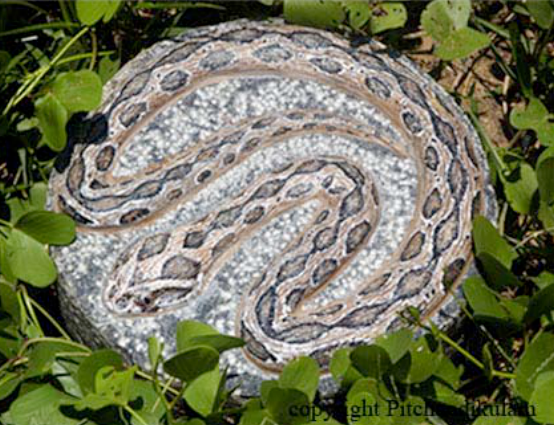
Image 9. A disused grinding stone carved and painted to represent a Russell’s Viper Daboia russelii . Placed among herbage it has caused some consternation among the uninitiated. Pitchandikulam Forest, Auroville.